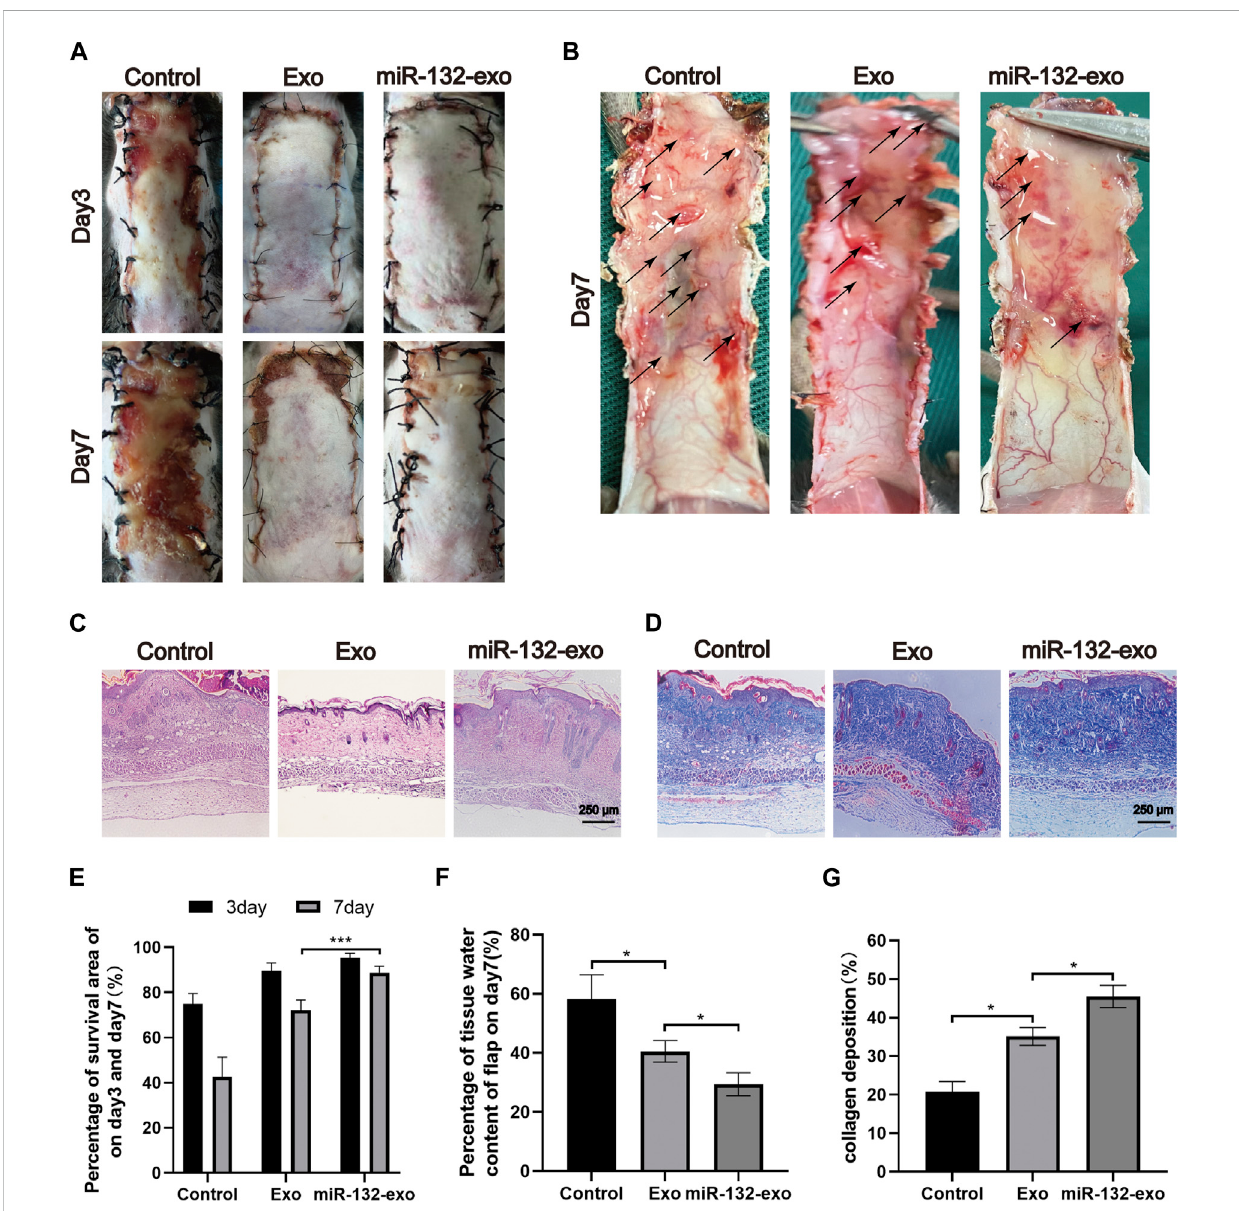
FIGURE 4 ThemiR-132-exo amelioratedthesurvivalofdiabeticrandomskin fl aps invivo . (A) Grossobservationimagesofdiabeticrandom skin fl apsonthethirdand seventhdayaftertreatmentwithnormalsaline,exosomes,andmiR-132-exo; (B) Imagesre fl ectedthetissueedemaonpostsurgeryday7,theedematous fl aparea ismarkedwithablackarrow; (C) H&Estainingimagesofthethreegroupsonday7; (D) Massonstainingimagesofthethreegroupsonday7,scalebar=250 μ m; (E) Quantitative analysis of the percentage of survival area in three groups; (F) The percentage of tissue water content of the skin fl aps in each group; (G) Quantitative analysis of collagen deposition in each group. * p < 0.05, ** p < 0.01, *** p < 0.001, data are presented as the mean ± SD, n >